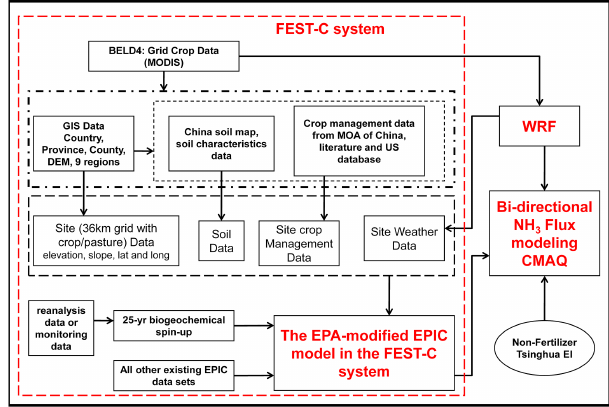
Figure 1. The modeling system of agricultural fertilizer NH 3 emis- sion for